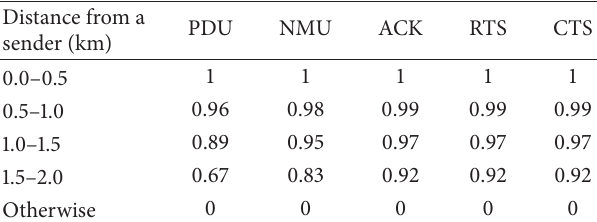
Table 2: The characteristics of a wireless link in terms of delivering a message between a sender and a receiver. (Each column except the first one represents the probability that a message corresponding to its first row is received at a receiver without an error.)